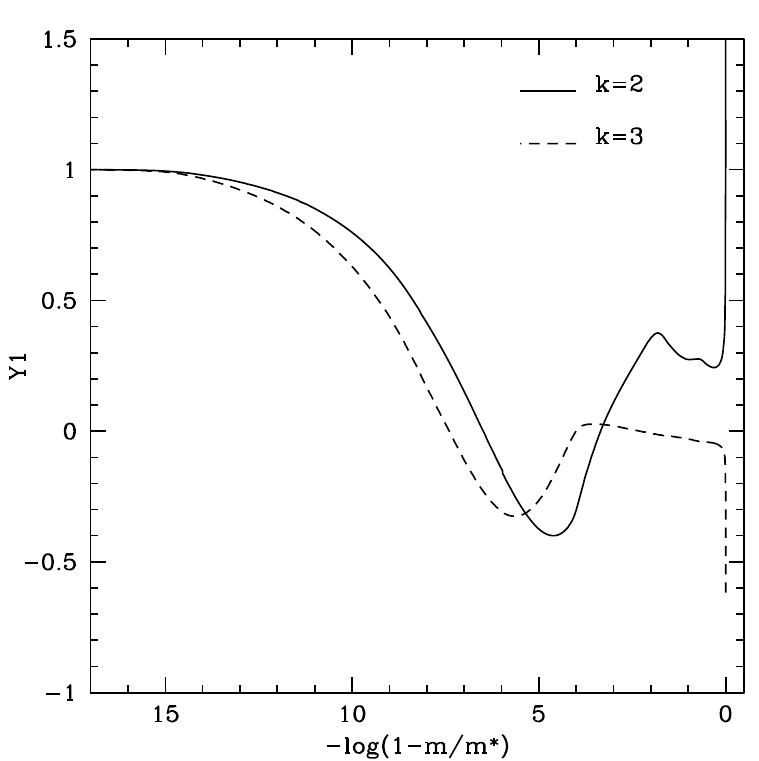
= δ r/r ) for the best model of ZZ Fig. 5. Radial perturbation ( Y 1 Ceti calculated by Bradley (1998) shows that the eigenfunction for the k = 3 mode, which corresponds to the 274 s periodicities, has negligible amplitude from the center [ log (1– M/M ∗ ) = 0] to the envelope [ log (1– M/M ∗ ) ≤ 4], compared to the k =2 mode, which corresponds to the 213 s